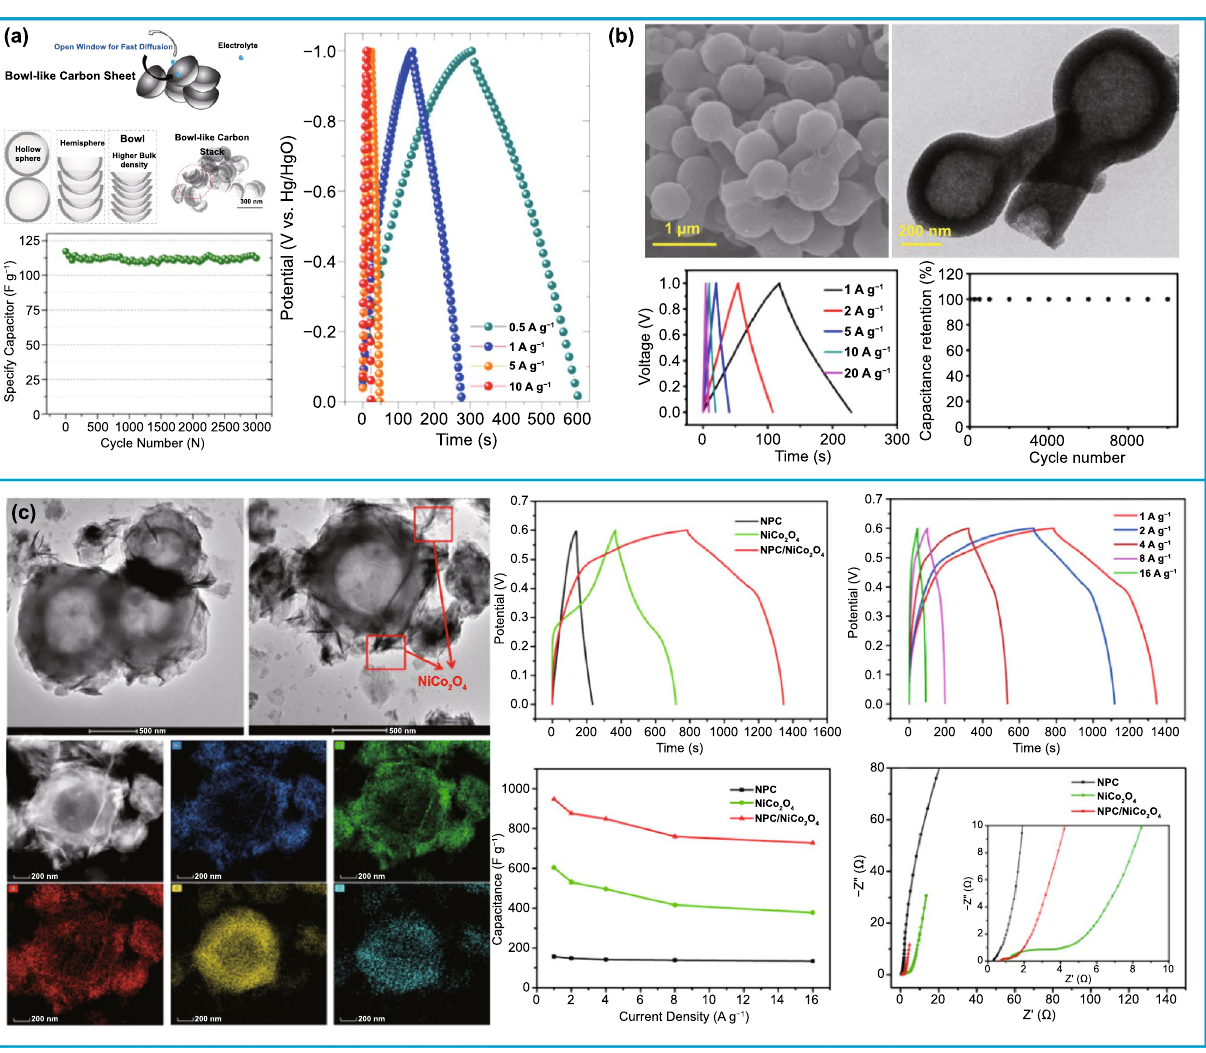
Fig. 11 Application of asymmetric structure in capacitors. a Application of asymmetric pure carbon in capacitor. Reproduced with permission from Ref.[29]. Copyright 2014, Elsevier B.V. b Application of flask-like pure carbon in capacitor. Reproduced with permission from Ref.